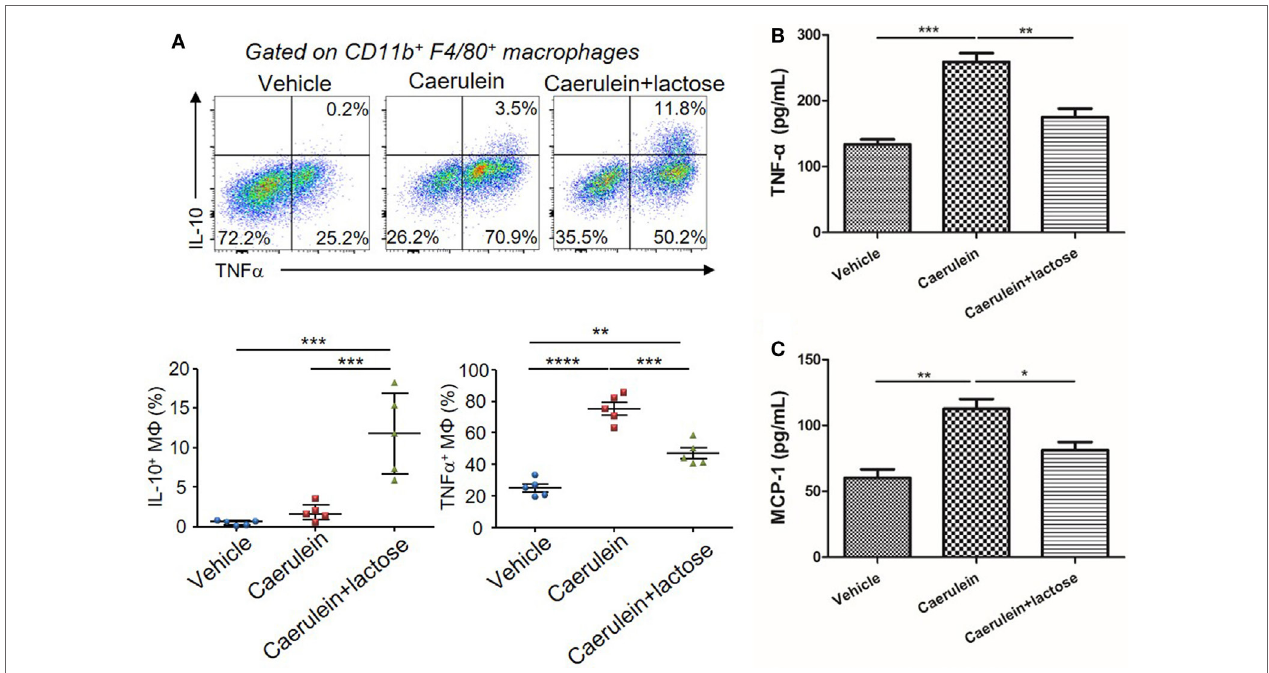
FigUre 4 | Lactose modulates macrophage infiltration, phenotypes and cytokine production during early acute pancreatitis. Female BALB/c mice were treated with caerulein together with or without lactose and 3 h later cells were recovered from the pancreas. (a) Pancreatic cells were stimulated 4 h with LPS (1 µg/ml) in the presence of brefeldin A and then stained for IL-10 and tumor necrosis factor alpha (TNF- α ). Data are representative or median values ± interquartile range from two independent experiments with a minimum of five independent mice. (B,c) Peritoneal macrophages were isolated from peritoneal exudate cells followed by a recovery period and then stimulated with lipopolysaccharides (1 µg/ml) for 3 h and the levels of TNF- α (B) and monocyte chemotactic protein-1 (c) production were determined. Results are mean ± SEM from at least three independent experiments of at least five independent mice in each group. * p < 0.05, ** p < 0.01, *** p < 0.001 by one-way analysis of